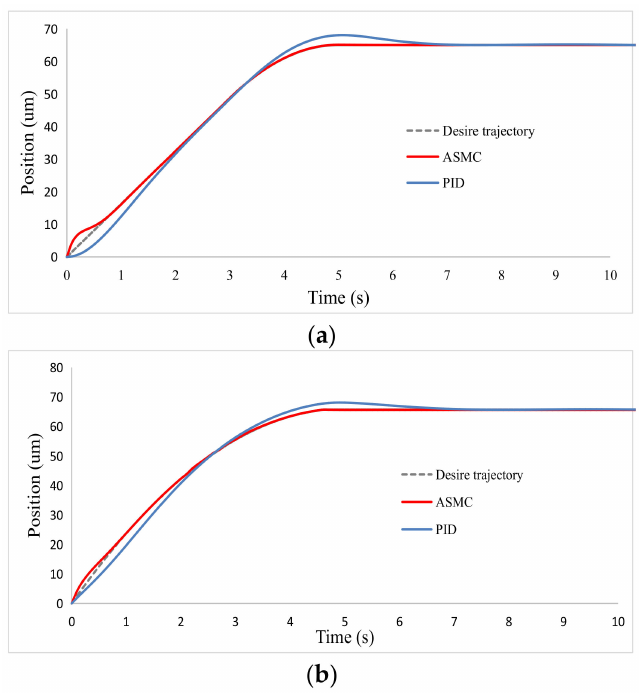
Figure 6. Controller simulation control results. ( a ) Ramp trajectory tracking control result. ( b ) Quadratic trajectory tracking control